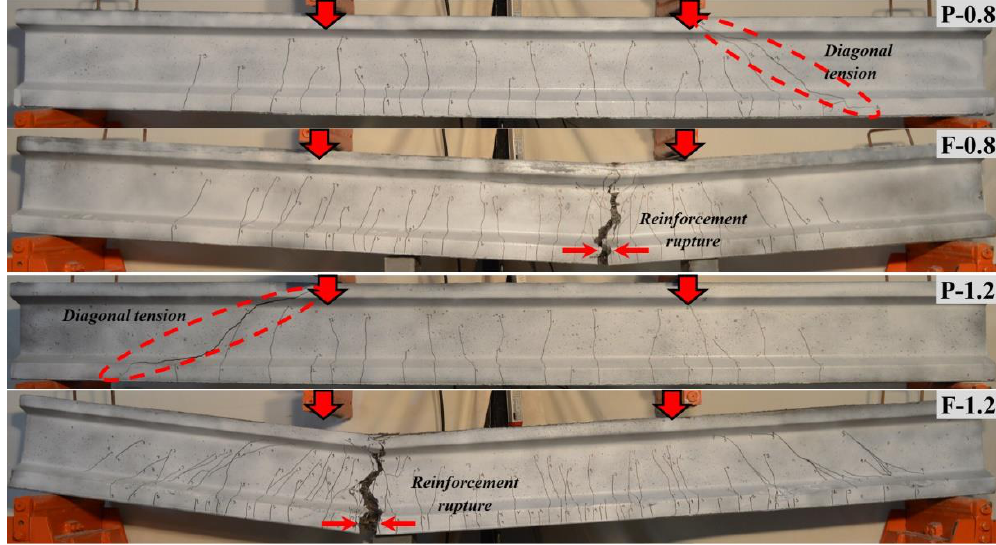
Figure 7. Comparison of failure modes for the test beams with low reinforcement ratios.